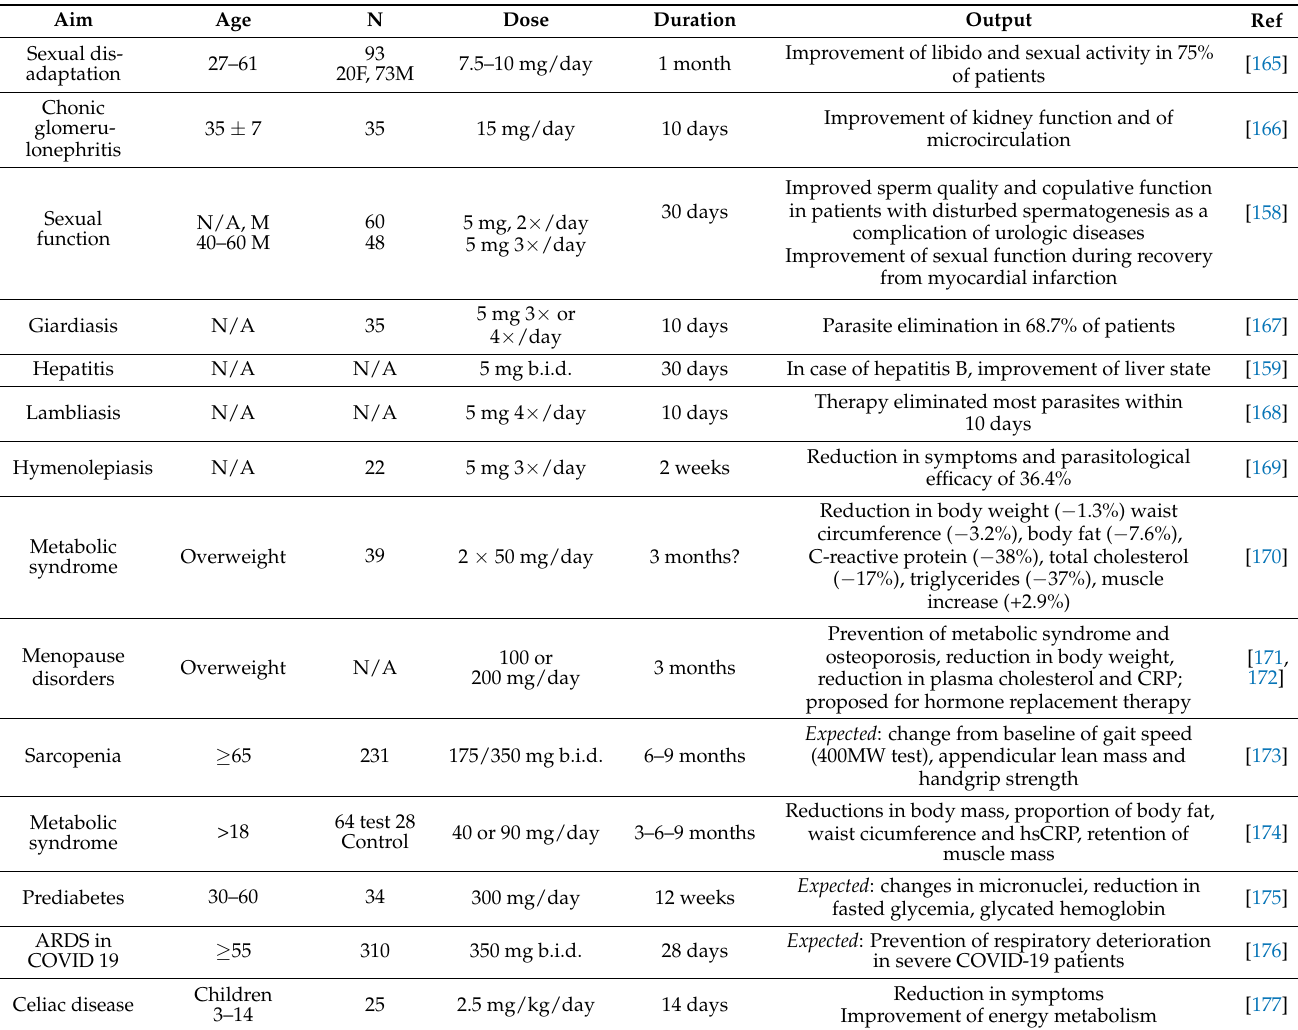
Table 7. Clinical studies on humans using pure